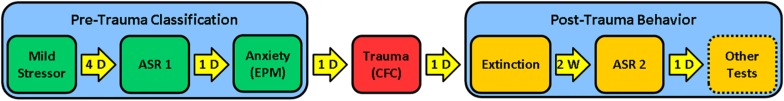
RISP model: Stage 1 (Pre-trauma classification): Rats are briefly stressed with a mild stressor (a ball of cat hair). Four days later, they are classified as Resilient (RES), Susceptible (SUS), or Intermediate (Int) based on their acoustic startle response (ASR1) and anxiety-like behavior in the Elevated Plus Maze (EPM); Stage 2 (Psychogenic trauma): Rats experience foot shock-motivated contextual fear conditioning (CFC) as a psychogenic trauma; Stage 3 (Post-trauma phenotype): Fear extinction and post-trauma startle (ASR2) are assessed. The original presentation of the model does not include other tests aligned with a complex PTSD-like phenotype, but these can be performed to evaluate cognitive and anxiety-like behavior after trauma. D = day; W = week.